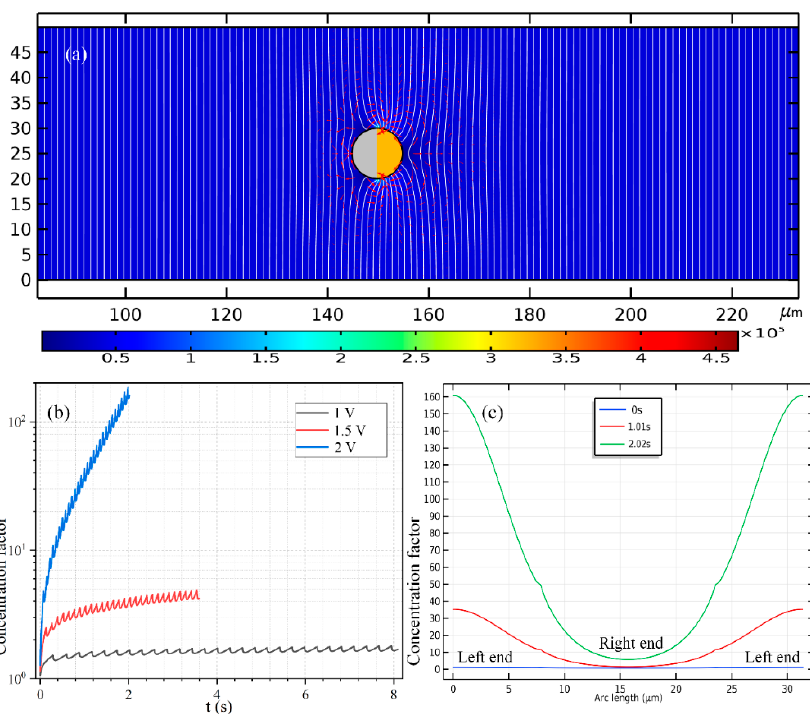
Figure 9. ( a ) The positive DEP velocity field of the nanoscale biomolecules dispersed in the liquid suspension around the Janus ME having an asymmetric induced dipole moment in the high-frequency limit, which is on the order of 10 − 10 –10 − 7 m / s and can thereby be ignored in comparison with the hydrodynamic flow e ff ect. ( b ) The peak concentration factor of the target biomolecules on the surface of the Janus ME as a function of time for varying AC voltages at f = 10 MHz, and the translating speed of the PP equals 23.46 µ m / s for 1 V, 52.9 µ m / s for 1.5 V, and 94 µ m / s for 1.5 V. ( c ) The concentrating factor along the surface of the Janus PP at distinct time instants once the sinewave generator with an AC voltage of 1.5 V at f = 10 MHz is switched on.